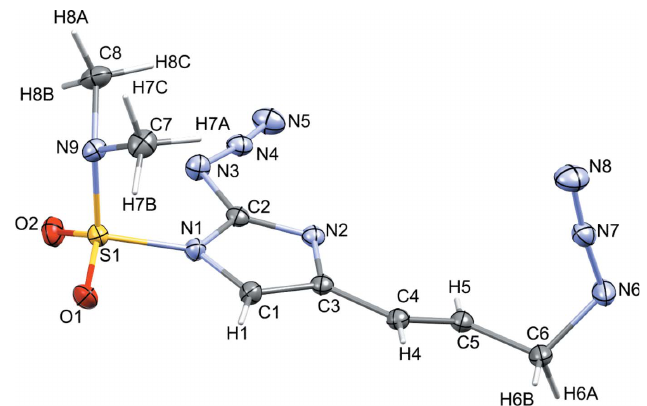
Figure 2 The molecular structure of compound 2 , with atom labels and 50% probability displacement ellipsoids for non-H atoms.